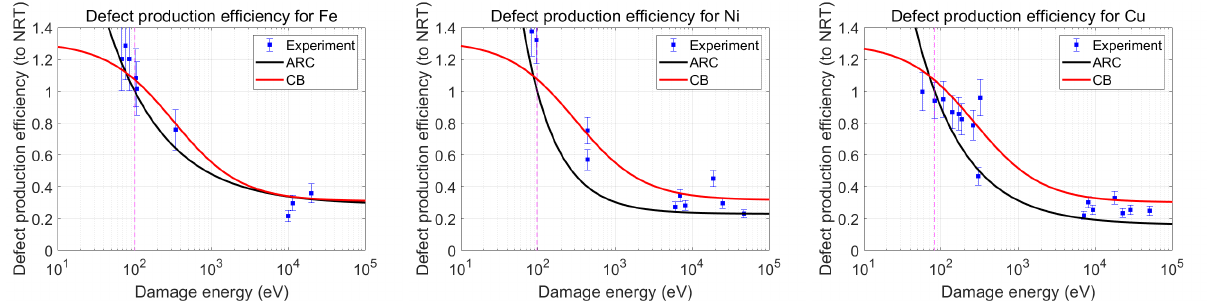
Figure 1. Ratios of experimental data, ARC-DPA, and CB-DPA to the NRT formula for Fe, Ni, and Cu versus damage energy. The dashed pink lines indicate 2 . 5 E d . The experimental data are extracted from Nuclear Energy Agency (NEA) report [12], which accounts for the experimental measurements of Jung [13]. The experimental uncertainties are deduced from Tables 5 and 16 in Ref. [13] through the Resistivity of Frenkel pairs per unit concentration, to which the number of DPA is proportional